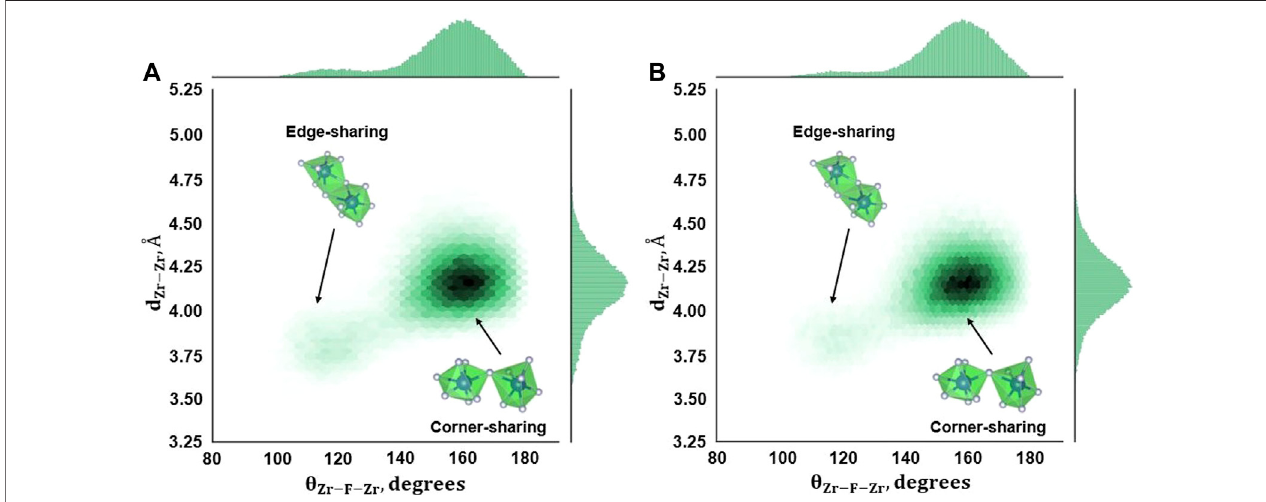
FIGURE 6 | Zr – F – Zr Angle distribution from RIM-IPMD calculations for (A) Composition B, 727 ° C, and (B) Composition C, 700 ° C.